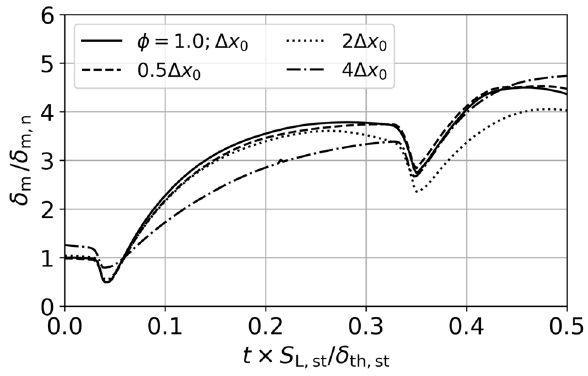
Figure 9. Convergence study of the normalized mixing width for φ